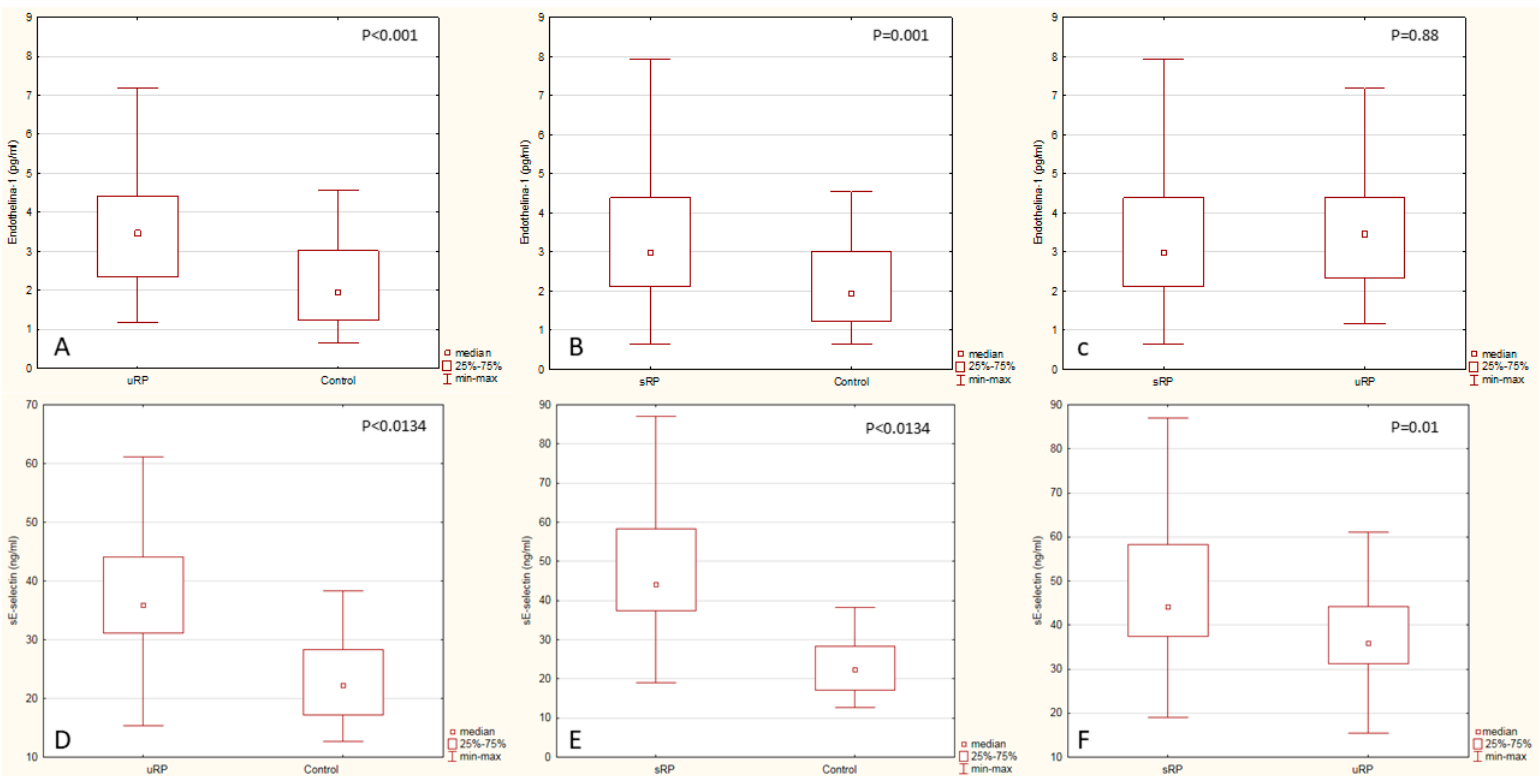
Figure 4. ( A ) Comparison of endothelin-1 concentration in the uRP group vs. endothelin-1 concentration in the control group ( p < 0.001). ( B ) Comparison of endothelin-1 concentration in the sRP group vs. endothelin-1 concentration in the control group ( p = 0.001). ( C ) Comparison of endothelin-1 concentration in the sRP group vs. endothelin-1 concentration in the uRP group ( p = 0.88). ( D ) comparison of sE-selectin concentration in the uRP group vs. sE-selectin concentration in the control group ( p < 0.0134). ( E ) comparison of sE-selectin concentration in the sRP group vs. sE-selectin concentration in the control group ( p < 0.0134). ( F ) comparison of sE-selectin concentration in the sRP group vs. sE-selectin concentration in the uRP group ( p = 0.01).